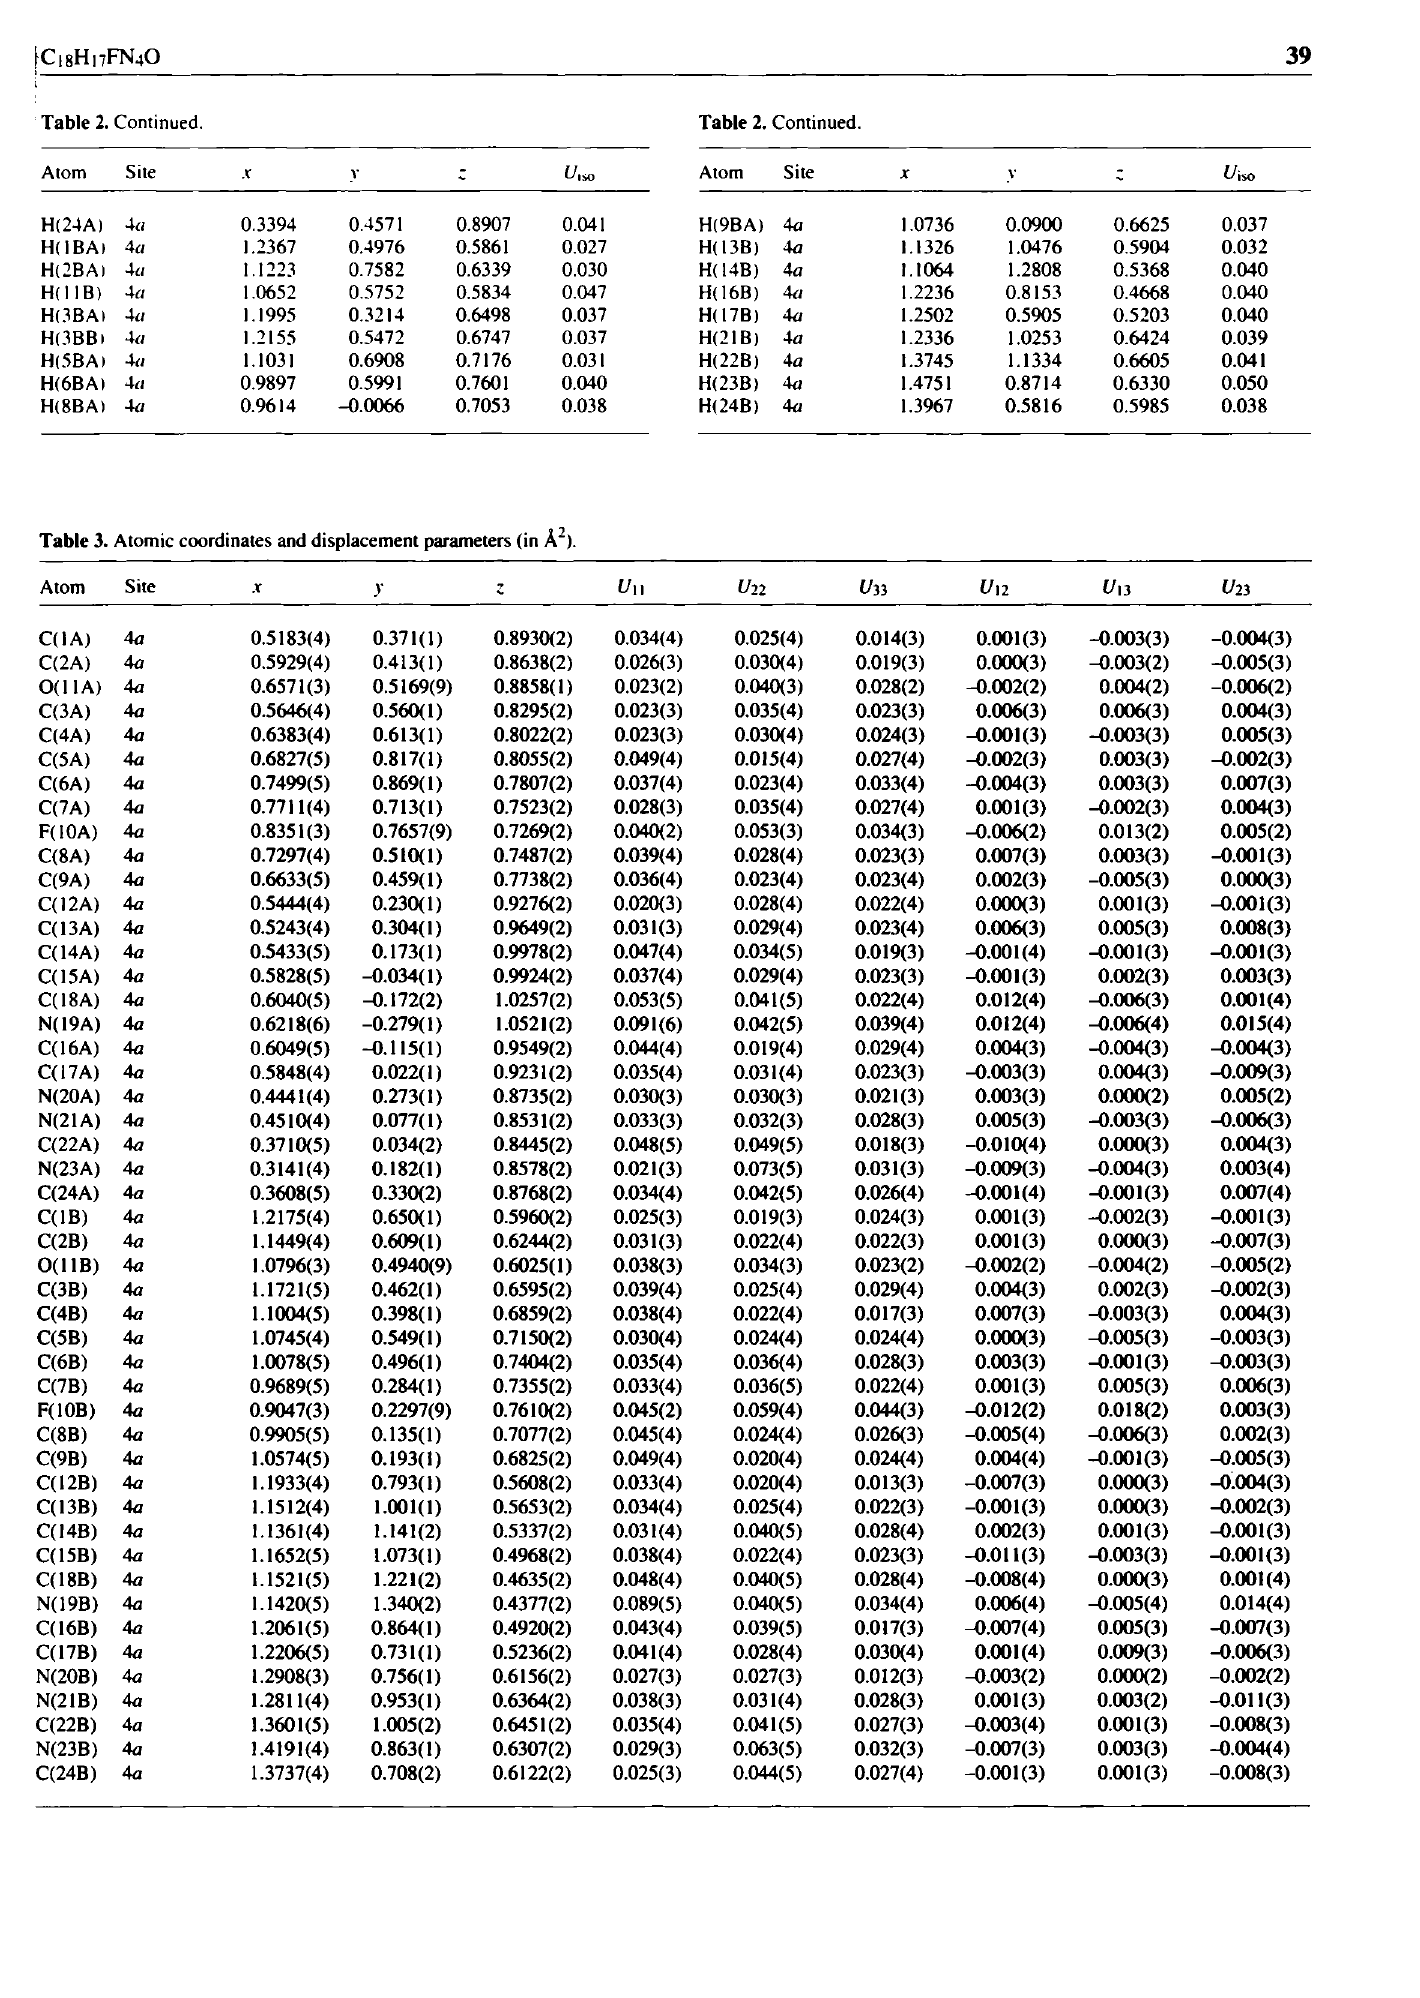
Table 3. Atomic coordinates and displacement parameters (in Â 2 ).